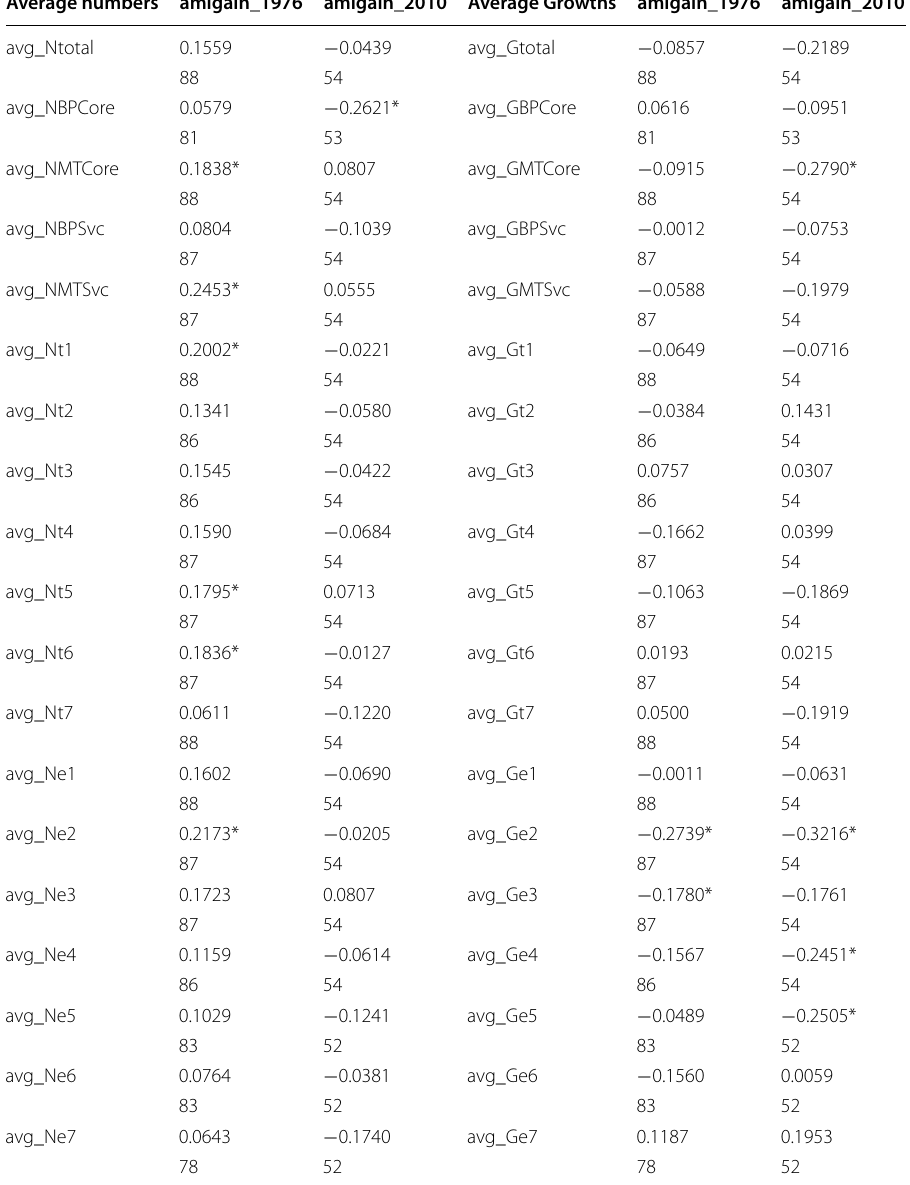
Table 4 Pairwise correlation between AMI gains and the average number of firms and the average